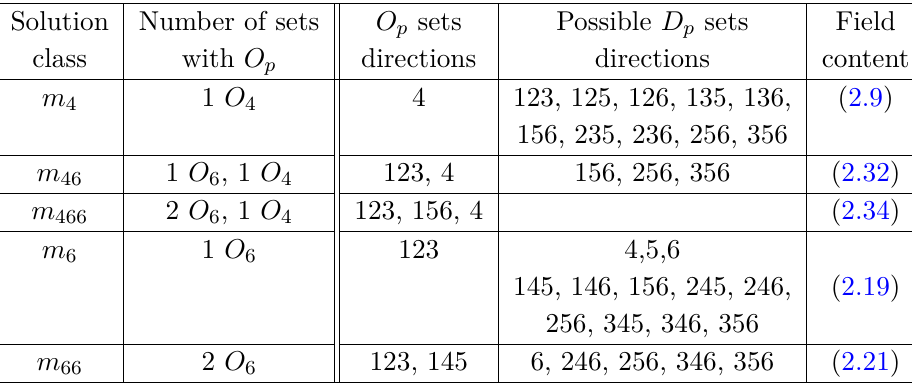
Table 3 . Source configurations in type IIA supergravity allowed by our ansatz for multiple di- mensionalities with at least one O , together with the associated list of allowed variables or field p content. These two pieces of information form together a solution class.